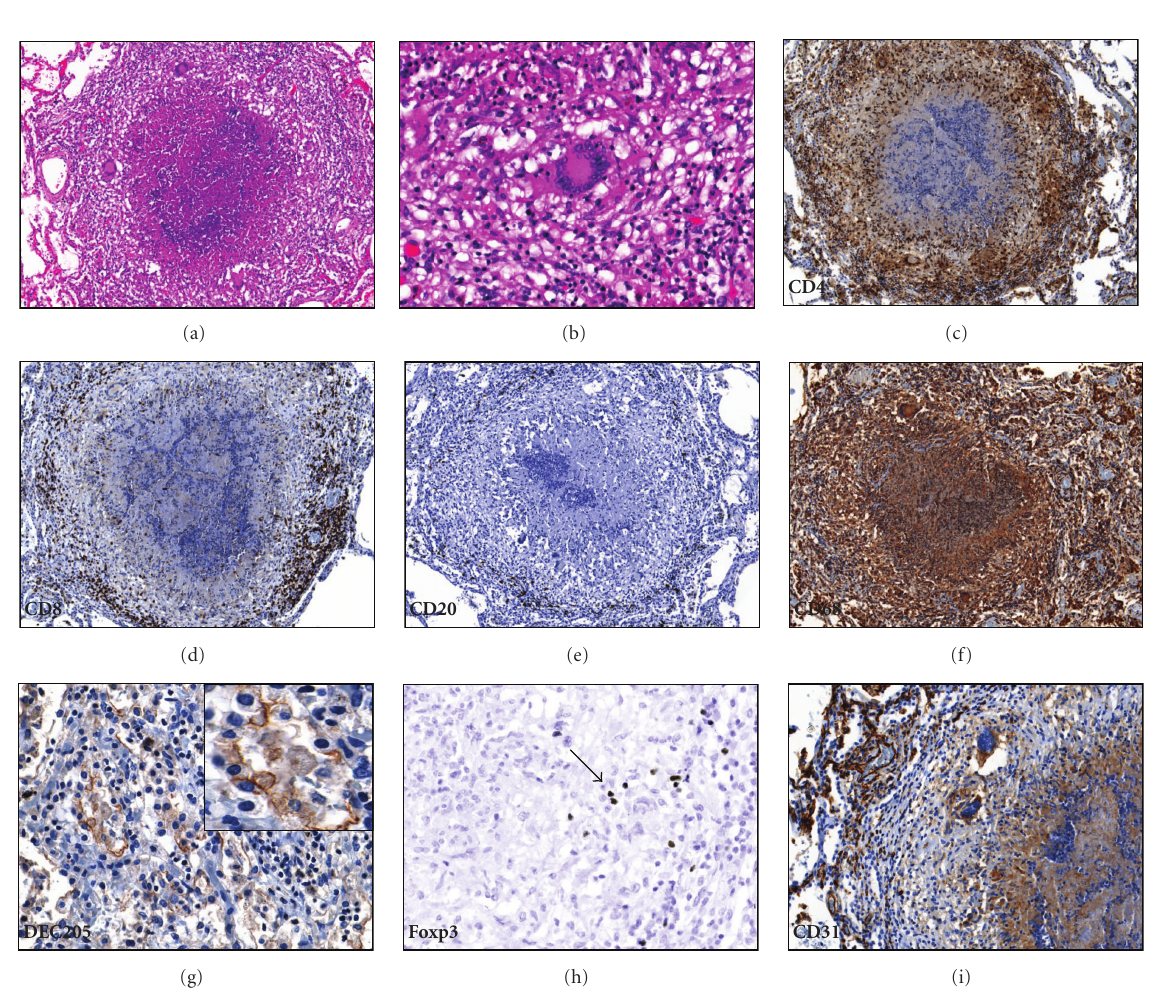
Figure 1: Granuloma histopathology. (a) Typical caseating granuloma, with central necrosis flanked by epitheliod cells and foamy macrophages. The periphery of the granuloma consists of lymphocytes, 100x. (b) Langhan’s giant cell, 400x. (c) Abundant CD4+ cells in the granuloma include both lymphocytes and macrophages, 100x. (d) CD8+ cells were mainly located in the periphery of the granuloma, 100x. (e) B-cells, identified by the CD20 stain, were noted in the outer layer of the granuloma. (f) Granulomas stained heavily for the CD68 marker, 100x. (g) Macrophages at the periphery of the granuloma stain positive for the dendritic cell marker DEC-205, 400x. The insert demonstrates a digitally zoomed region to detail the DEC-205 staining. (h) T-regulatory cells, identified by the Foxp3 marker (arrow), were found in the lymphocytic layer of the granuloma, 400x. (i) CD31 stain shows well-vascularized tissue at the periphery of the granuloma,